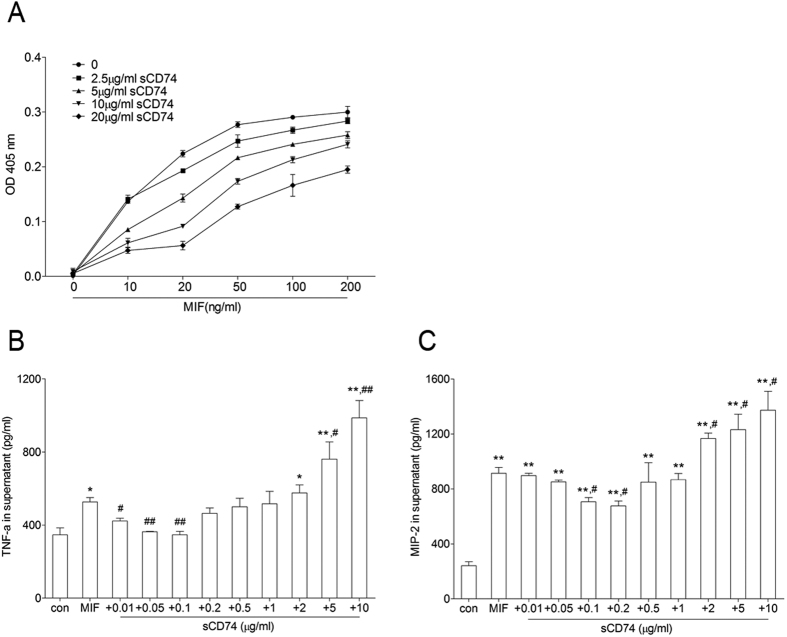
Effect of sCD74 on MIF bioactivity.(A) Recombinant mouse sCD74 inhibits MIF detection by ELISA method. (B,C) RAW264.7 cells were treated with control media and 100 ng/ml MIF with or without the presence of different concentrations of rmsCD74 for 24 hrs. After 24 hrs supernatants were collected and TNF-α and MIP-2 concentrations were measured by ELISA. Bar graphs represent the mean ± SEM of three independent experiments. *P < 0.05 and **P < 0.01 compared to control with Dunnett-t test after ANOVA for multiple comparisons, and #P < 0.05 and ##P < 0.01 compared to MIF group with same statistical methods.